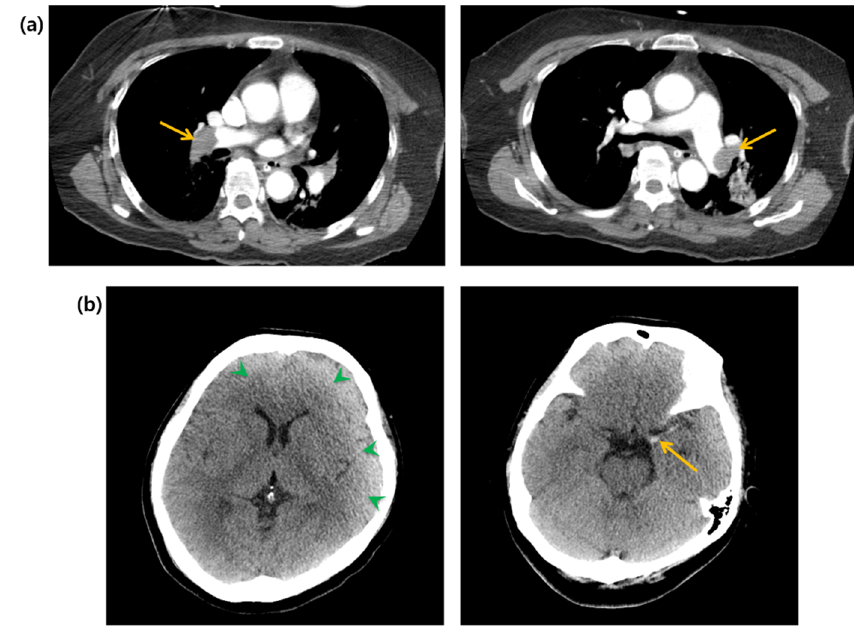
Figure 2. ( a ) Computed tomography of the chest. Arrows indicate massive pulmonary embolisms. ( b ) Computed tomography of the brain. Green arrowheads indicate widely decreased gray matter density. Yellow arrow indicates hyperdense middle cerebral artery sign.